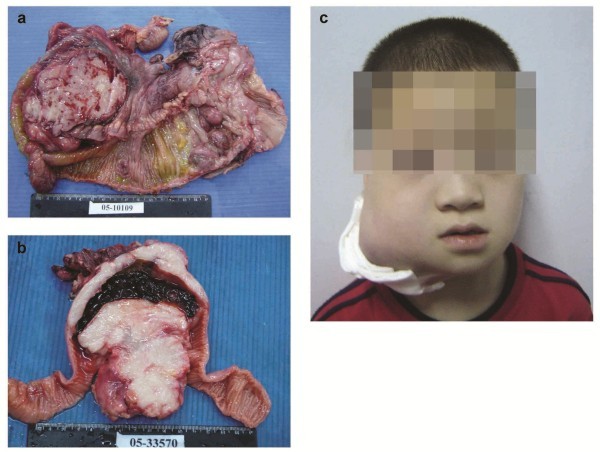
The macroscopic photograph of Burkitt lymphoma. (a) A 12-years boy presented with abdominal lesions. There was a huge mass within the mesentery and multiple polyploid lesions were present in the cecum; (b) a 6-years boy had a jejunum mass, with thickening of intestinal wall and hemorrhage; (c) an 8-years boy presented with a big facial bone mass.